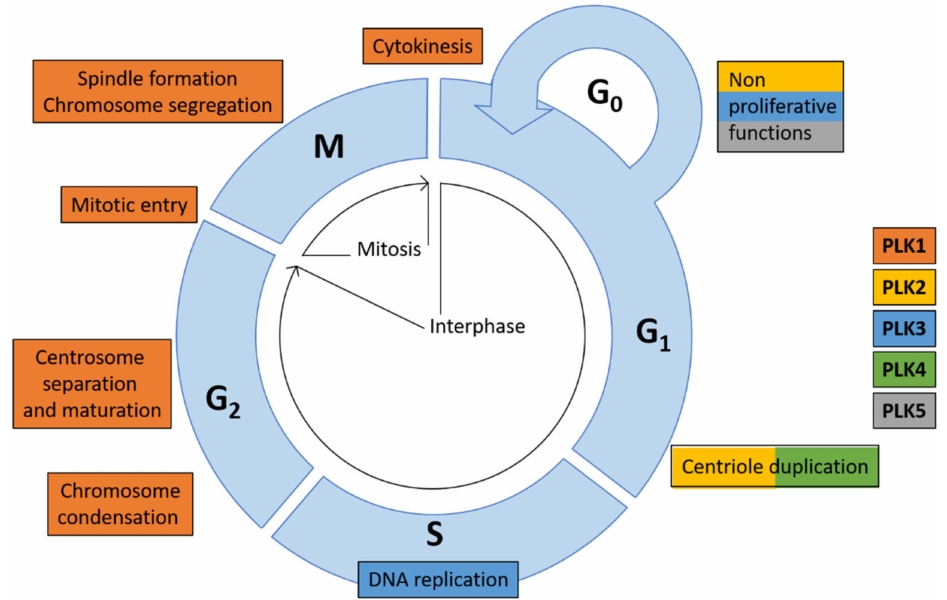
Figure 2. Functions of PLK family members in cell cycle [16]. PLK family members are essential for cell cycle processes, such as centriole duplication (PLK2 and PLK4), DNA replication (PLK3), chromosome condensation, centrosome separation and maturation, mitotic entry, spindle formation and chromosome segregation and cytokinesis (all PLK1). Besides cell cycle-related functions PLKs exert a multitude of vital cellular functions being part of complex signaling